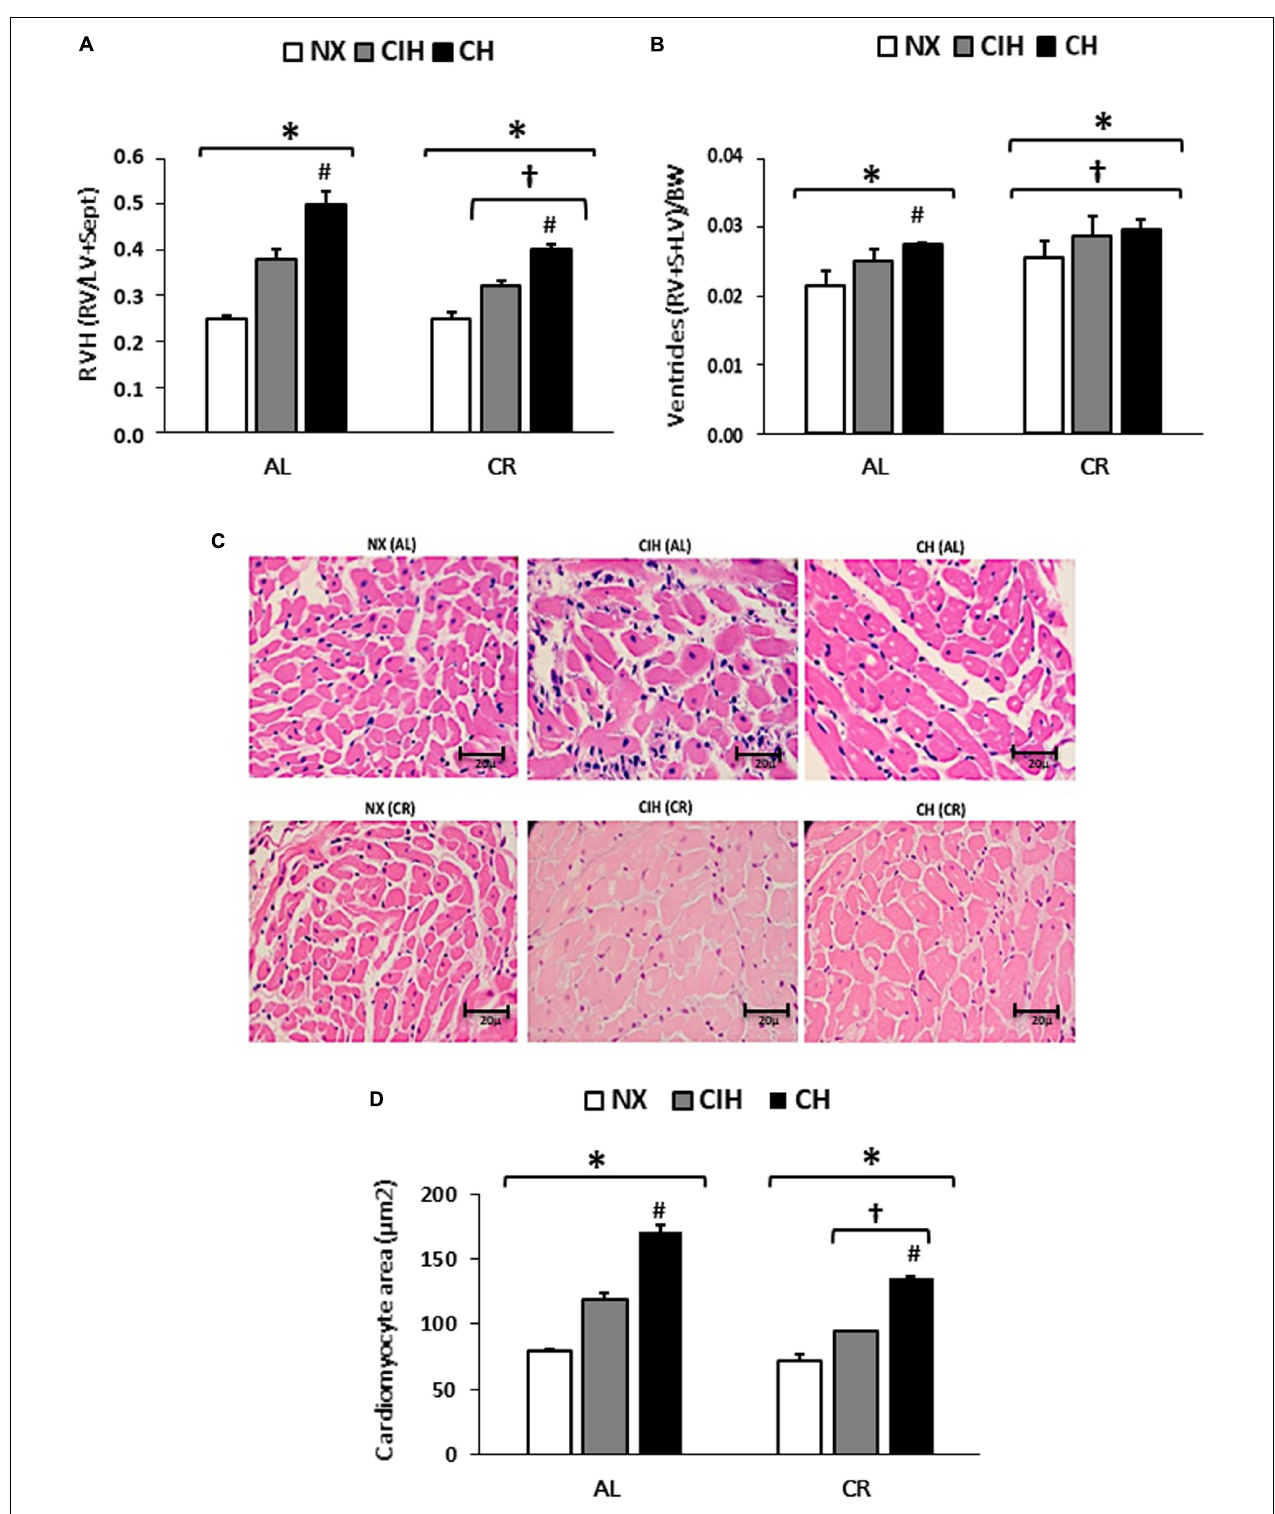
FIGURE 2 | Grade of right ventricular hypertrophy (RVH): Ad libitum (AL) and caloric restriction (CR) groups on day 30: normoxic group (NX), chronic intermittent hypoxia group (CIH), and chronic hypoxia group (CH). (A) Expressed as Fulton’s index [right ventricle (RV) weight/(left ventricle (LV) weight + septum weight)]. (B) Ventricles (RV+S+LV)/BW ratio. (C) Hematoxylin and eosin staining of the slices of the RV and (D) of the cardiomyocyte area of the RV. The values are the mean ( ¯ x) ± standard error (SE). ∗ p < 0.05: hypoxia-exposed vs. NX; # p < 0.05: CIH vs. CH. † p < 0.05: AL vs. CR.